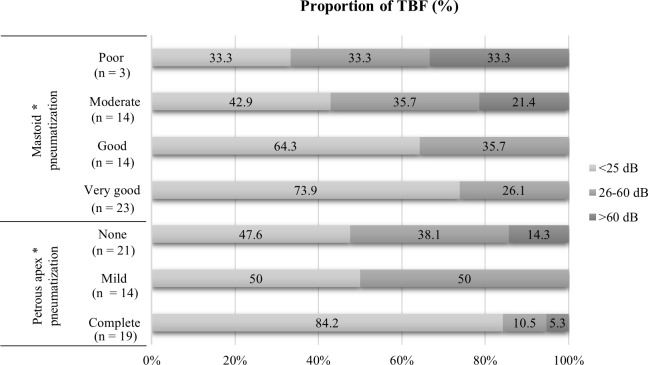
Proportion of temporal bone fractures with sensorineural hearing loss (SNHL).The less pneumatized temporal bone tended to have the greater the possibility of SNHL and the more severe degree of SNHL. The severity of SNHL was stratified using the average bone conduction thresholds at 0.5, 1, 2, and 4 kHz. TBF, temporal bone fracture; asterisk, statistically significant (P< 0.05).